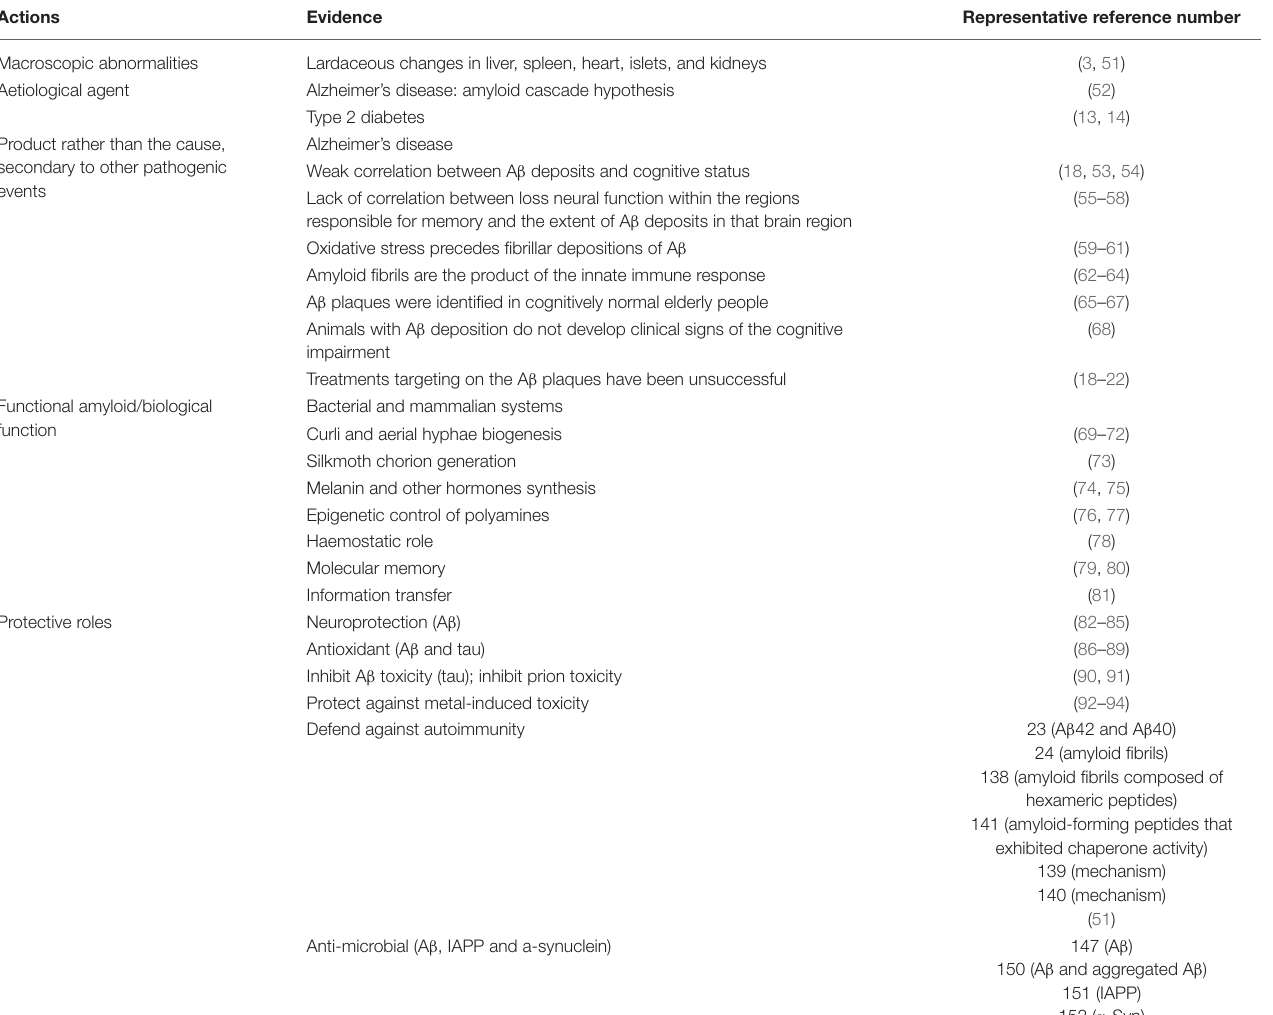
TABLE 2 | Specific actions of amyloid protein and deposition denoted in research